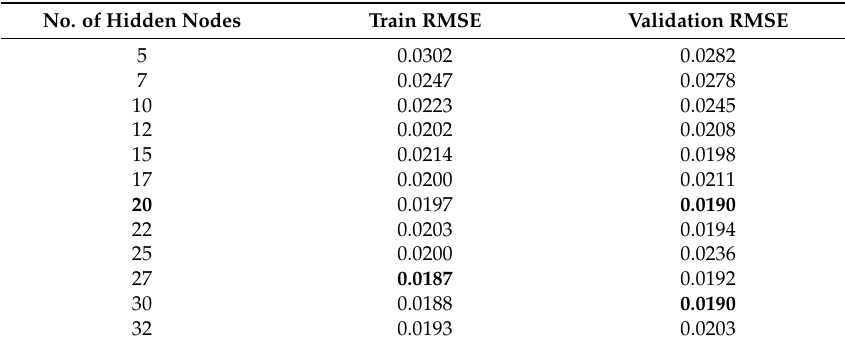
Table 2. Performance comparison of a single hidden layer neural network by varying the number of nodes in the hidden layer.